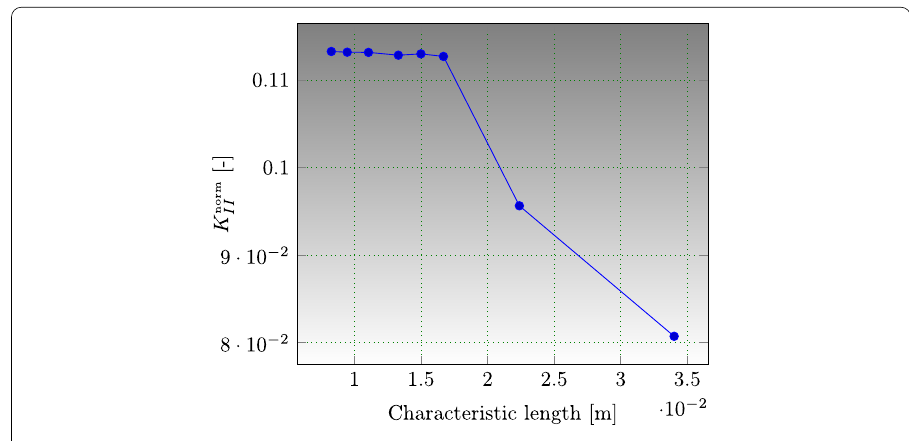
Fig. 13 Convergence of SIFs computation, square plate with round hole, R / L = 0 . 1 and l / L = 0 . 3